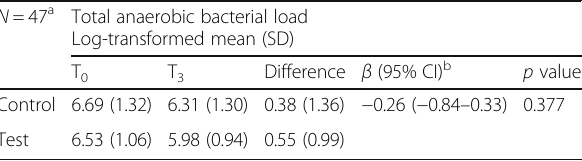
SD standard deviation a Three samples without bacterial growth and three samples without follow-up excluded from analysis b Linear regression analysis, adjusted for baseline